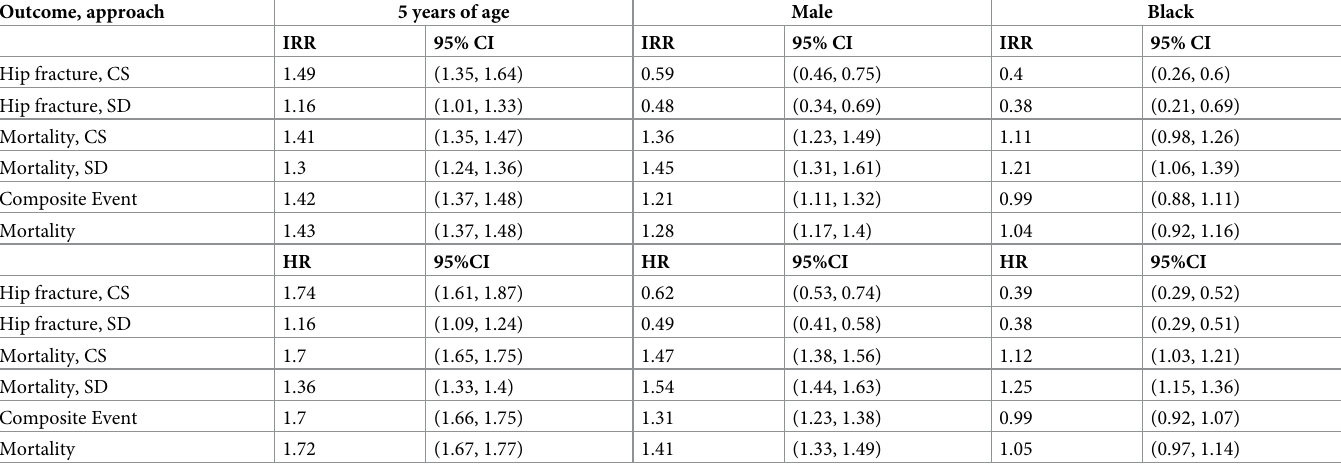
Table 3. Incidence rate ratios and hazard ratios estimates for incident hip fracture, mortality and composite event in model